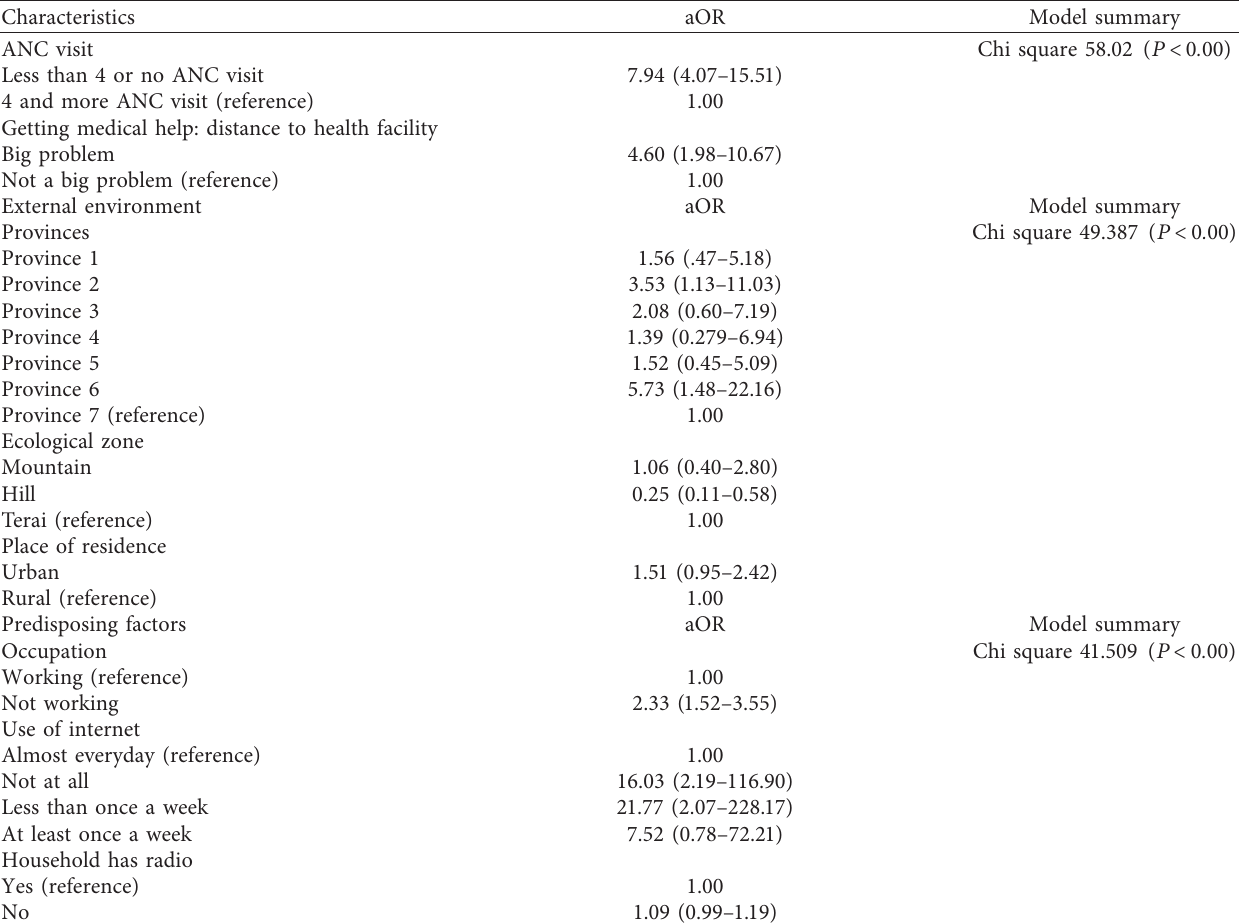
Table 5: Relationship between enabling resources, external environment, and predisposing factors with DTP1 Vs DTP3 dropout.